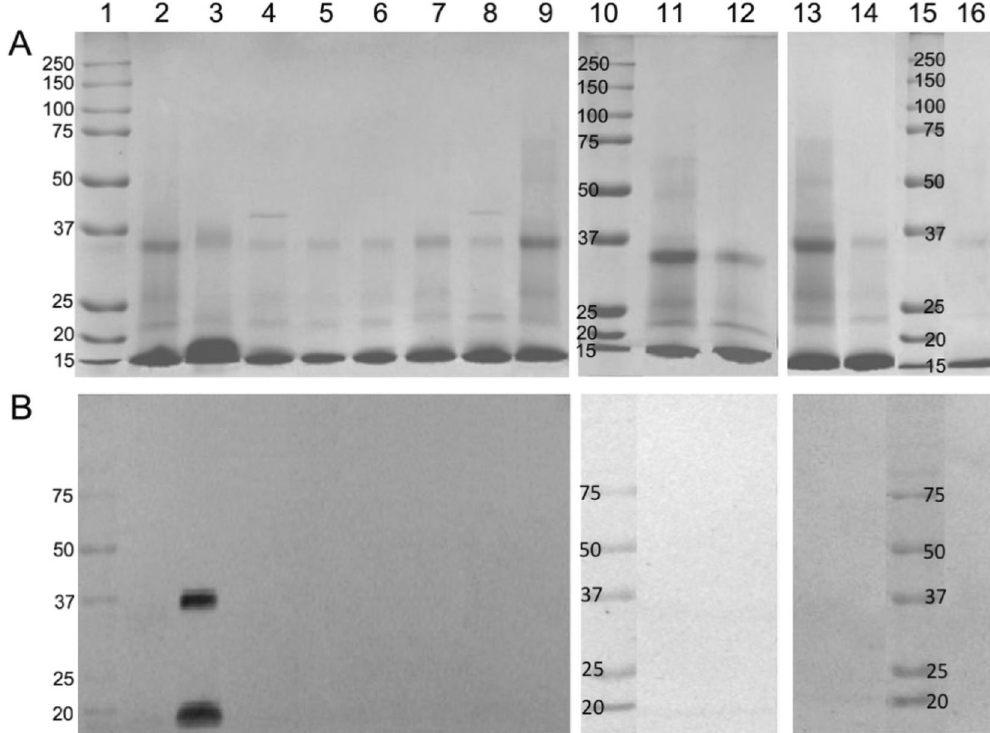
Figure 4. Reactivity of anti-MAGE mAb with the model glycation products. The MB (lane 16) was incubated in solution (lanes 2, 4, 6, 8, 11, 13) or in dry conditions (3, 5, 7, 9, 12, 14) with mel (2, 3), lac (4, 5), fru (6, 7), glc (8, 9), MGO (11, 12), GA (13, 14). The protein glycation products (50 µg/well) separated on 12.5% SDS-PAGE gel were stained with Coomassie Brilliant Blue ( A ) or transferred onto the membrane probed with the anti- MAGE/10 mAb ( B